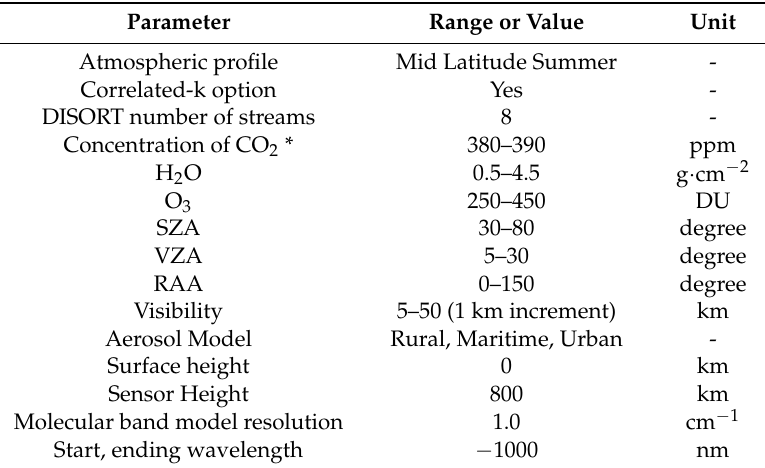
Table 3. Input parameters for MODTRAN4